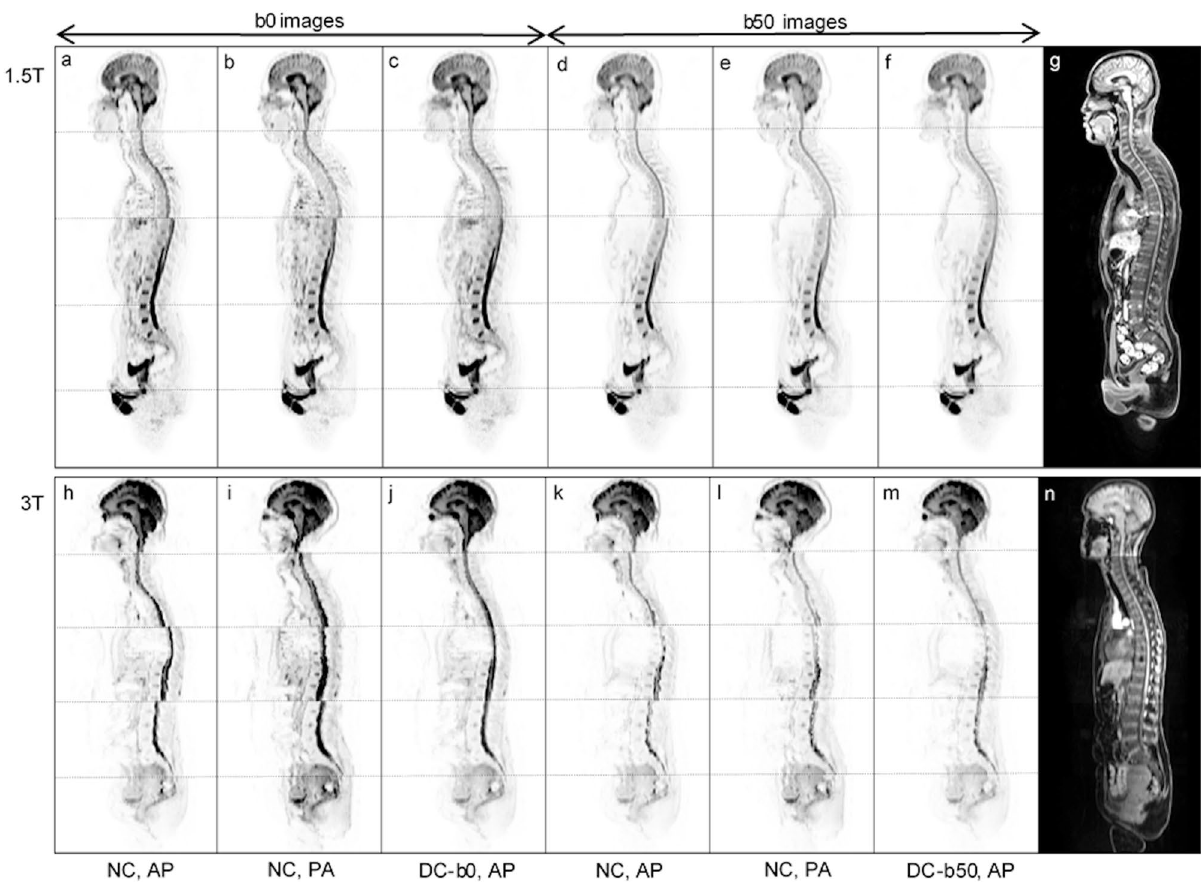
Figure 2. Representative examples of the susceptibility-induced distortion and the effect of distortion correction for sagittal b0 and b50 images at 1.5T (top row, a – g ) and 3T (bottom row, h – n ). For the b0 images, non-corrected (NC) anterior–posterior (AP) ( a , h ), NC posterior-anterior PA ( b , i ) and b0-based distortion corrected (DC-b0) AP ( c , j ) images are displayed. For the b50 images, NC AP ( d , k ), NC PA ( e , l ) and b50-based distortion corrected (DC-b50) AP ( f , m ) images are displayed. Corresponding structural images are also shown ( g , n ). DW images are shown in inverted grey-scale with station boundaries marked with a dotted line. Inter- station signal intensity correction was performed for the purpose of visualization 23 . Distortion is visible for the spine at station boundaries for NC images, and can be seen to be of opposing directions along the phase-encode direction for non-corrected AP and PA images. For the distortion corrected data the spine is linked at all station boundaries for both the b0- and b50-based corrections and its shape better matches that of the structural